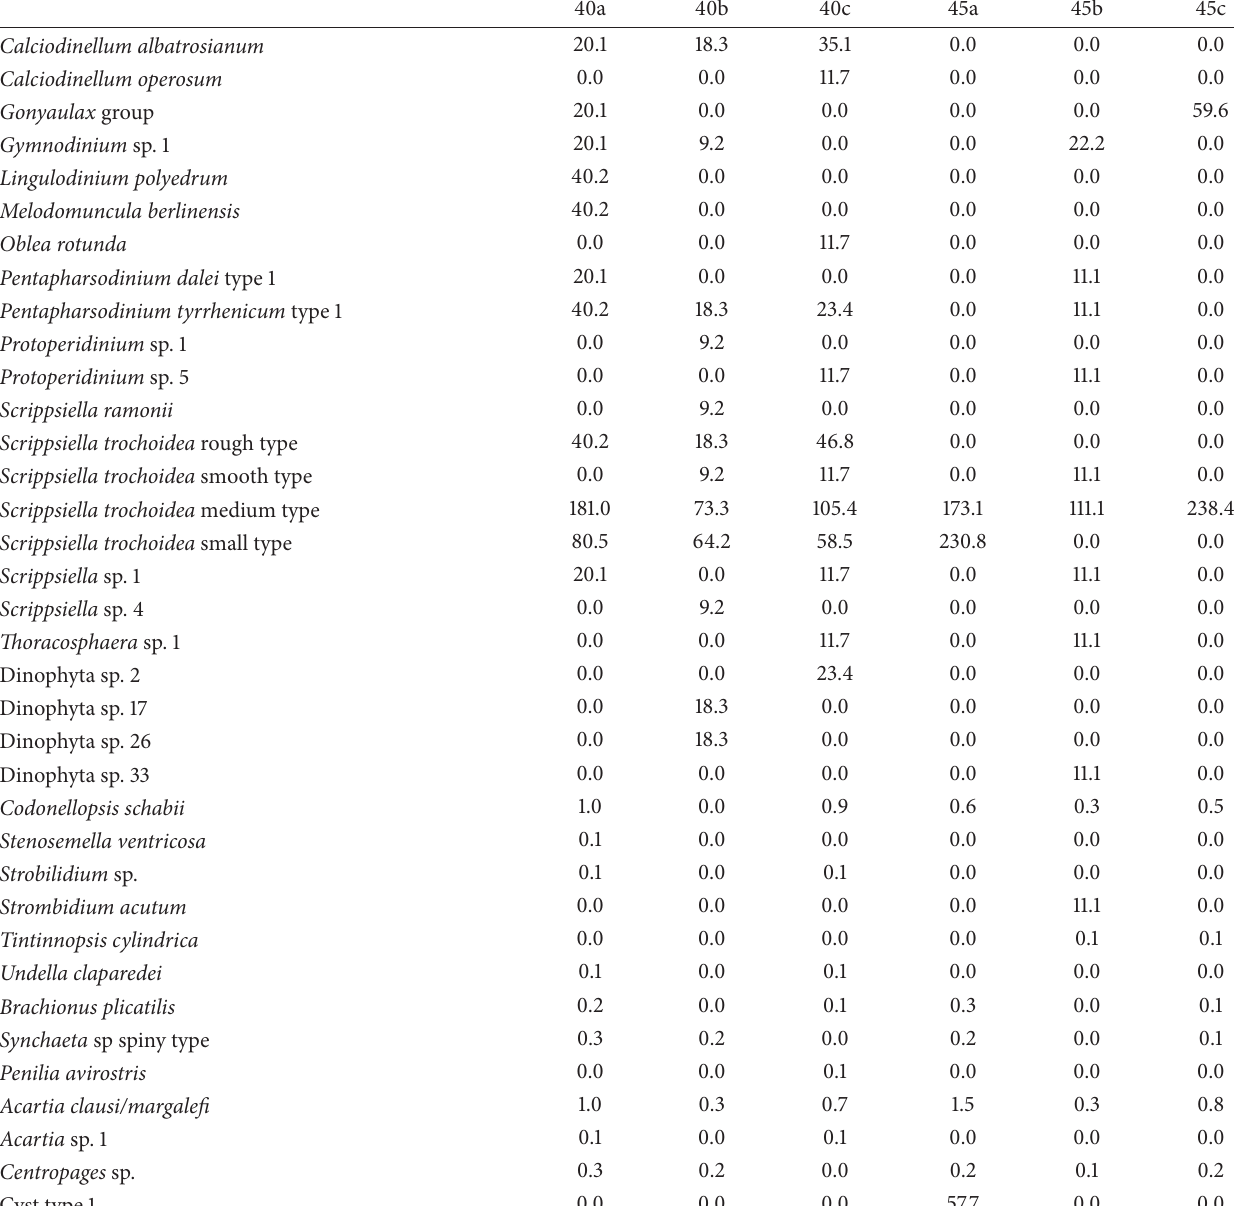
Table 2: Abundance (cystsg − 1 dw) of probably viable resting stages (cysts) observed in surface sediments of two stations in Bay of Vlor¨e (Albania). Values from three replicates are reported.